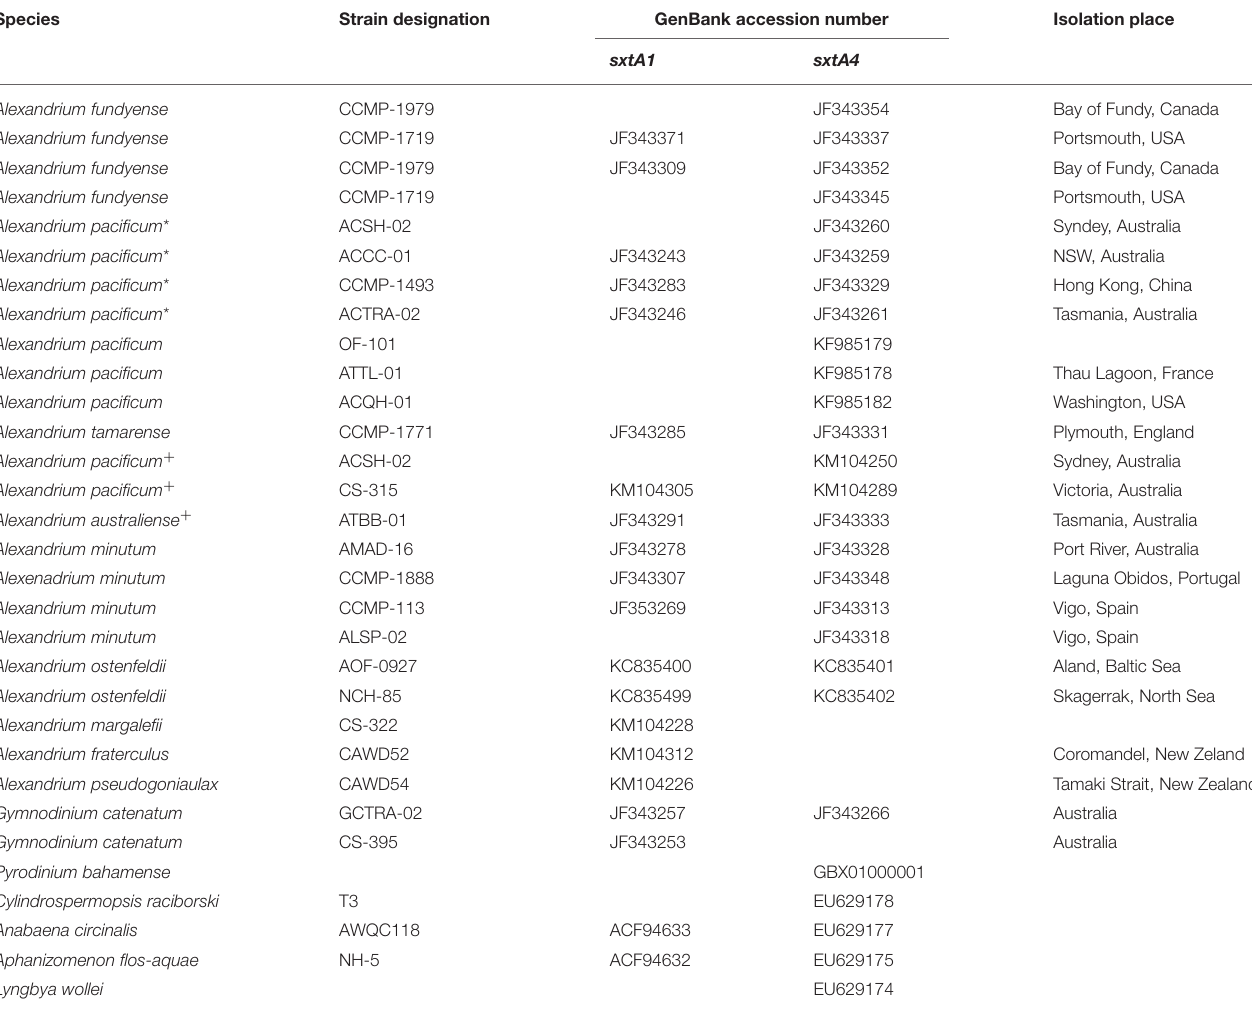
TABLE 3 | Strains and GenBank accession numbers of species used in phylogenetic analyses for the sxtA1 and sxtA4